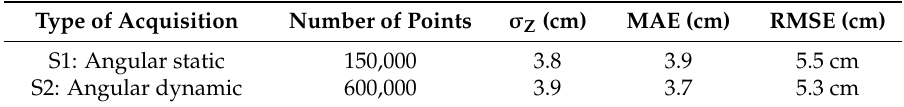
Table 3. Results of the uncertainty and accuracy assessment of LiDAR height measurements in angular and static dynamic